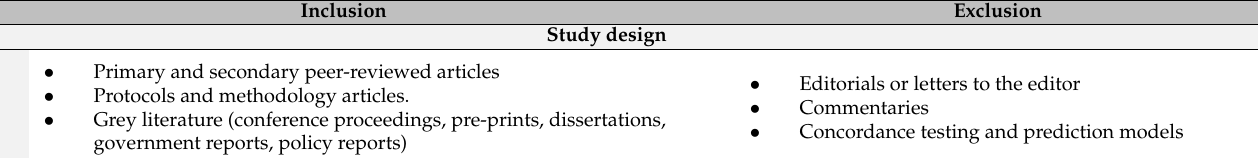
Table 1. Inclusion and exclusion criteria for record